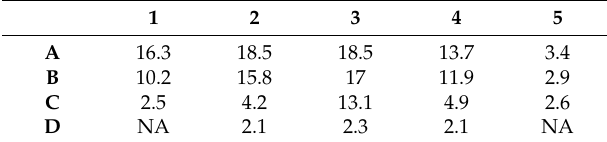
Table 3. SNR related to raw data captured by flash thermography.